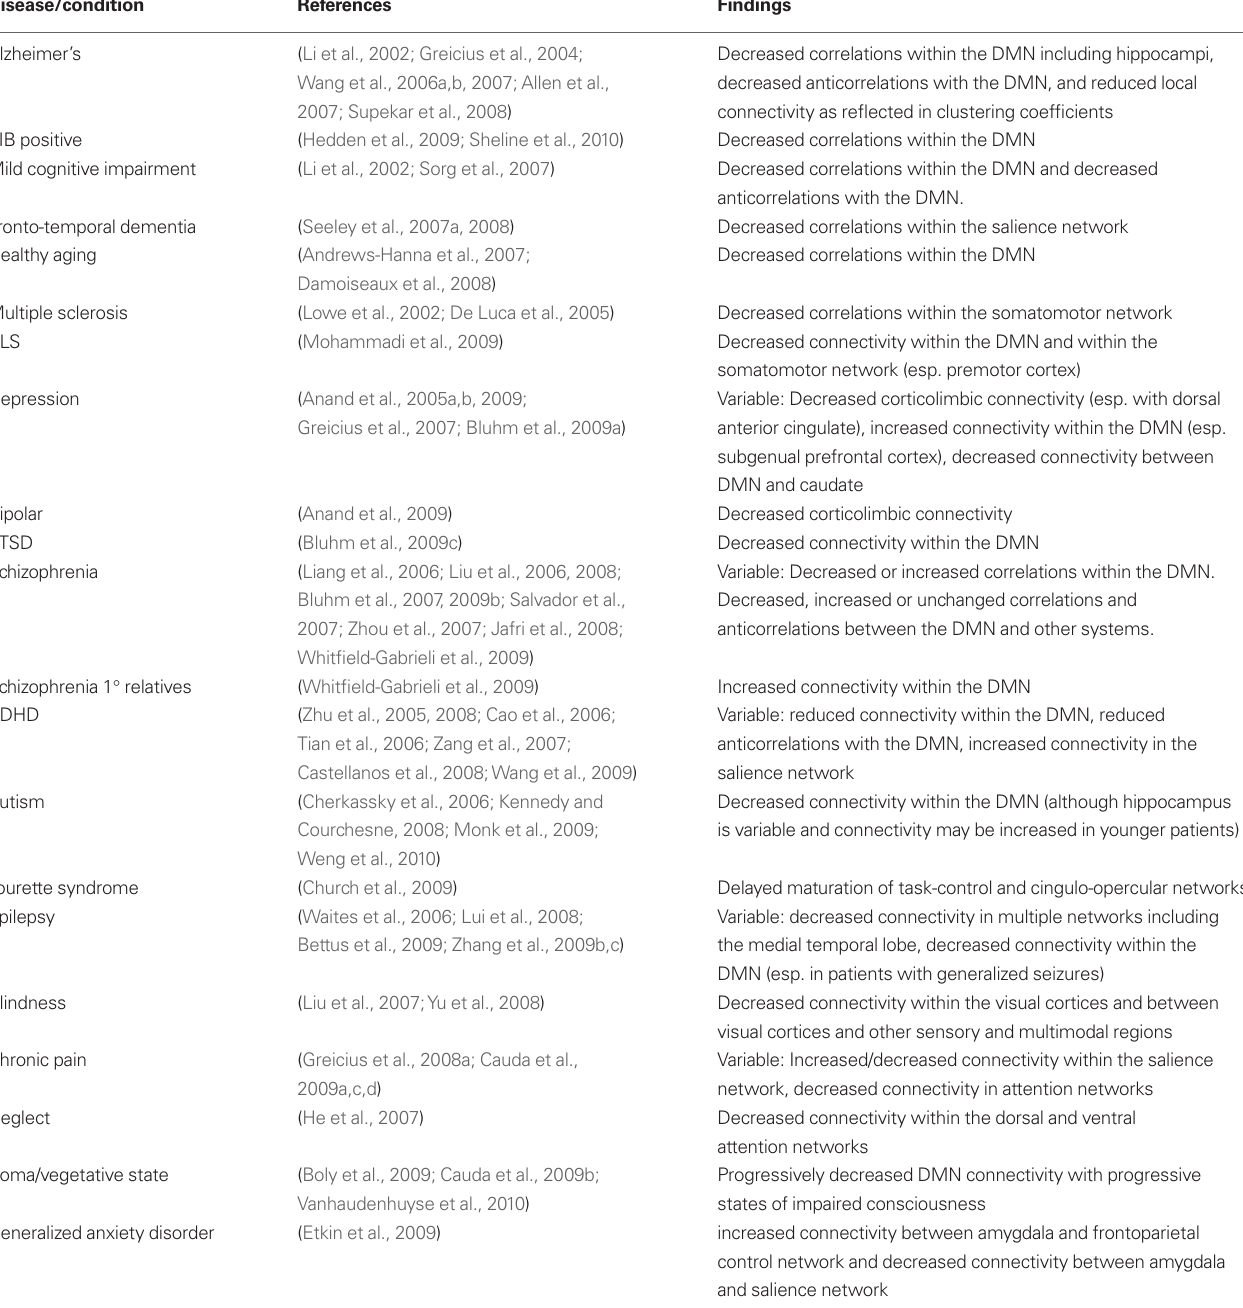
Table 1 | group differences in resting state fcMRI patterns observed in various brain diseases or conditions.